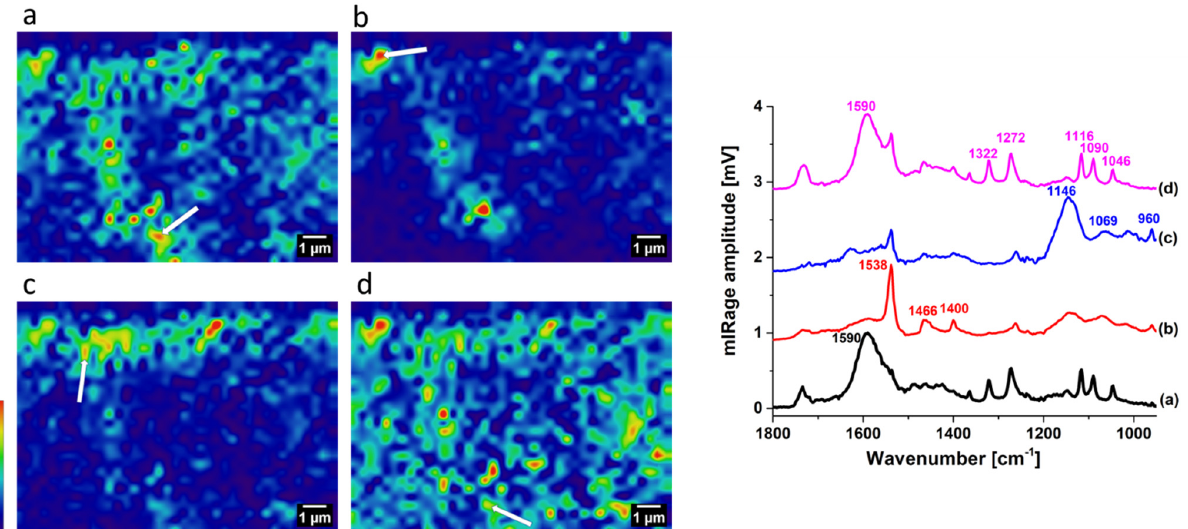
Figure 3. O-PTIR hyperspectral imaging from the centre spot (19 by 13.5 µm 2 ) and representative spectra: ( a ) amorphous zinc soap (1590 cm − 1 ), ( b ) crystalline zinc soap (1540 cm − 1 ), ( c ) gordaite (1146 cm − 1 ), and ( d ) zinc lactate (1270 cm − 1 ). Red denotes the highest intensity, and purple denotes the lowest intensity. Characteristics for selected wavenumber O-PTIR spectra were taken from the spots marked by white